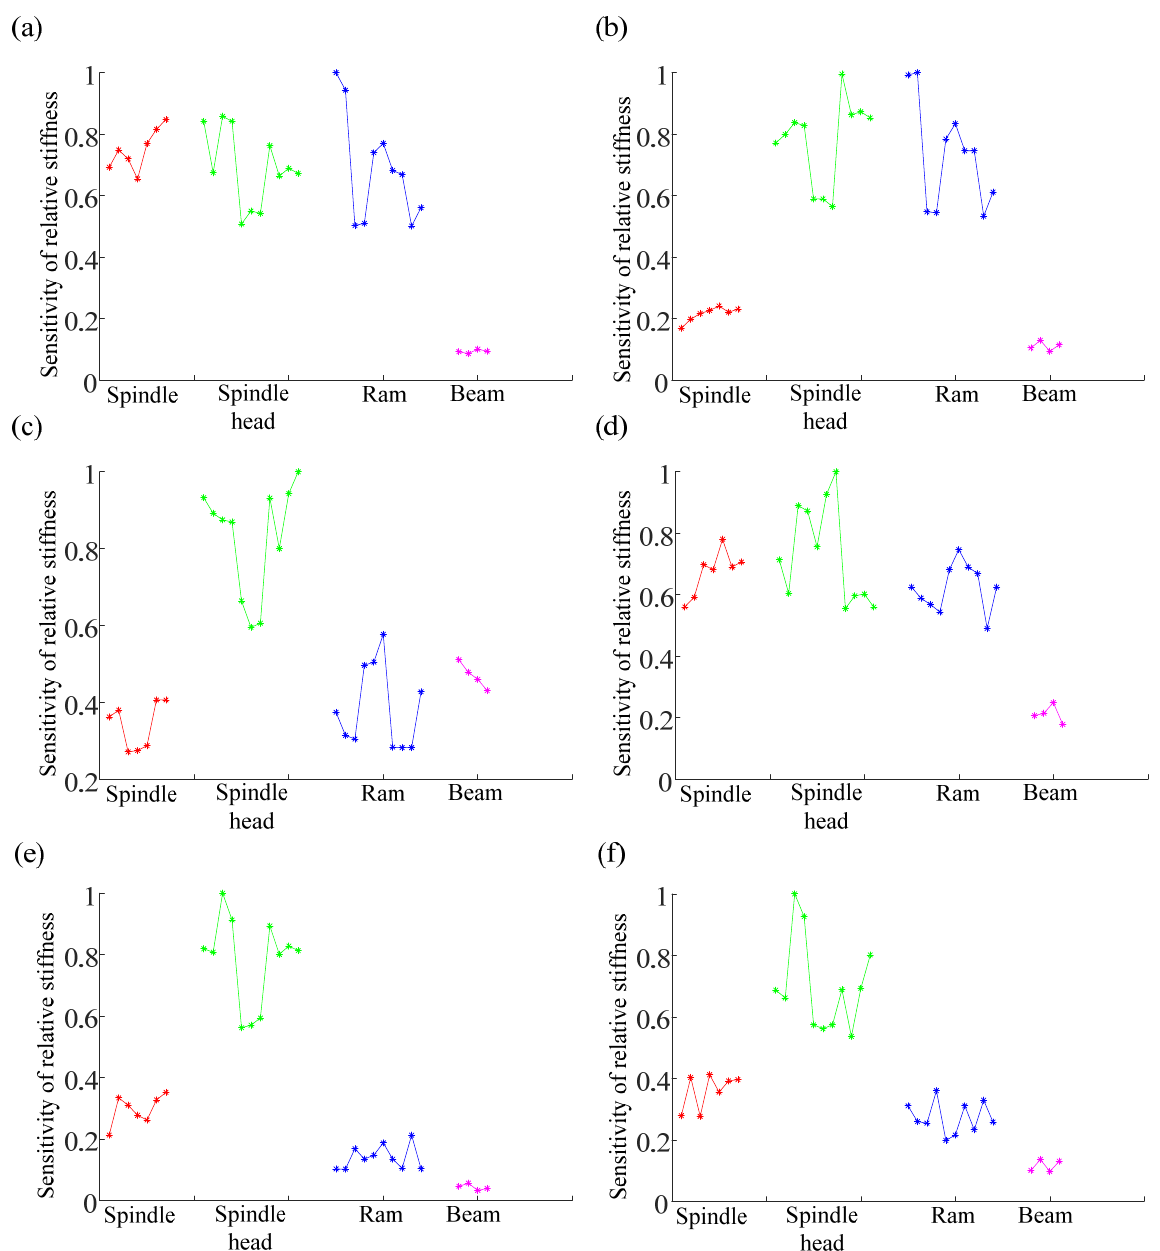
Figure 6. Modal dynamic stiffness sensitivity of each degree of freedom of each component of the machine tool: ( a )–( f ): t first mode to the sixth mode.